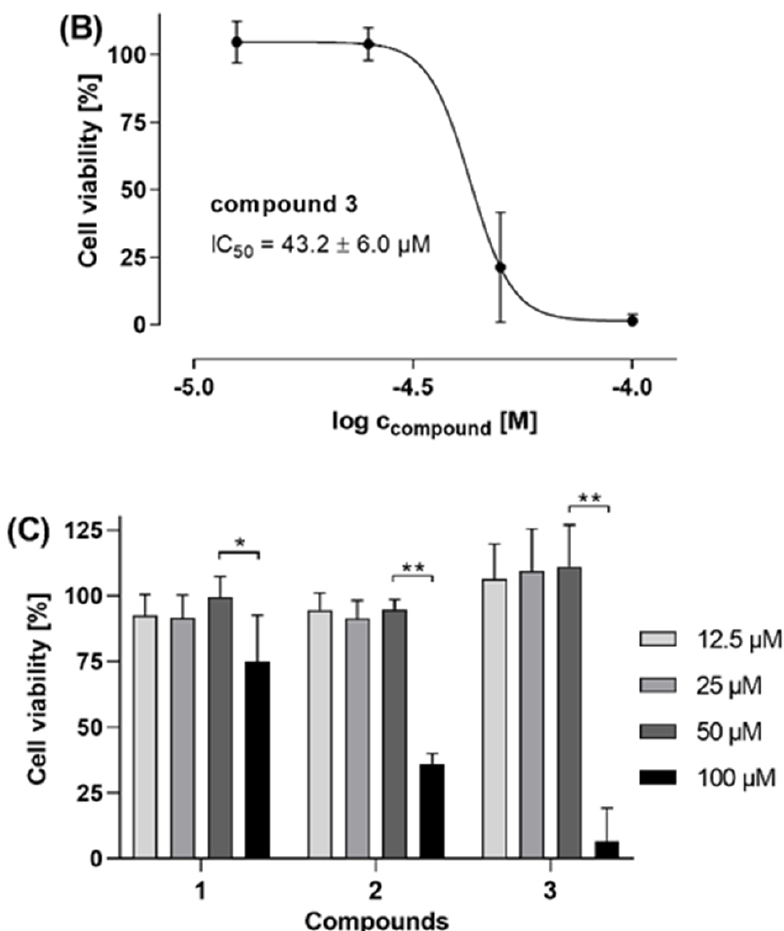
Figure 2. Effects of compounds 1 , 2, and 3 on the viability of ( A ) PC-3 (human prostate cancer) and ( C ) HT-29 (human colorectal cancer) cells, respectively. The IC 50 curve of compound 3 in PC ‐ 3 cells is shown in ( B ). After 48 h of compound treatment, the cell viability was measured by using a fluo ‐ rometric resazurin ‐ based assay. Data represent biological triplicates, each with technical quatrupli ‐ cates. Digitonin (100 μ M) was used as positive control compromising the cells to yield 0% cell via ‐ bility after 48 h. Data were analyzed by using GraphPad Prism 8. Statistical significances were eval ‐ uated by using Brown ‐ Forsythe and Welch one ‐ way ANOVA tests, including Tamhane’s multiple comparison test as well as ordinary one ‐ way ANOVA including Sidak’s multiple comparison test; in all cases with ** p < 0.0001, and * p < 0.05.